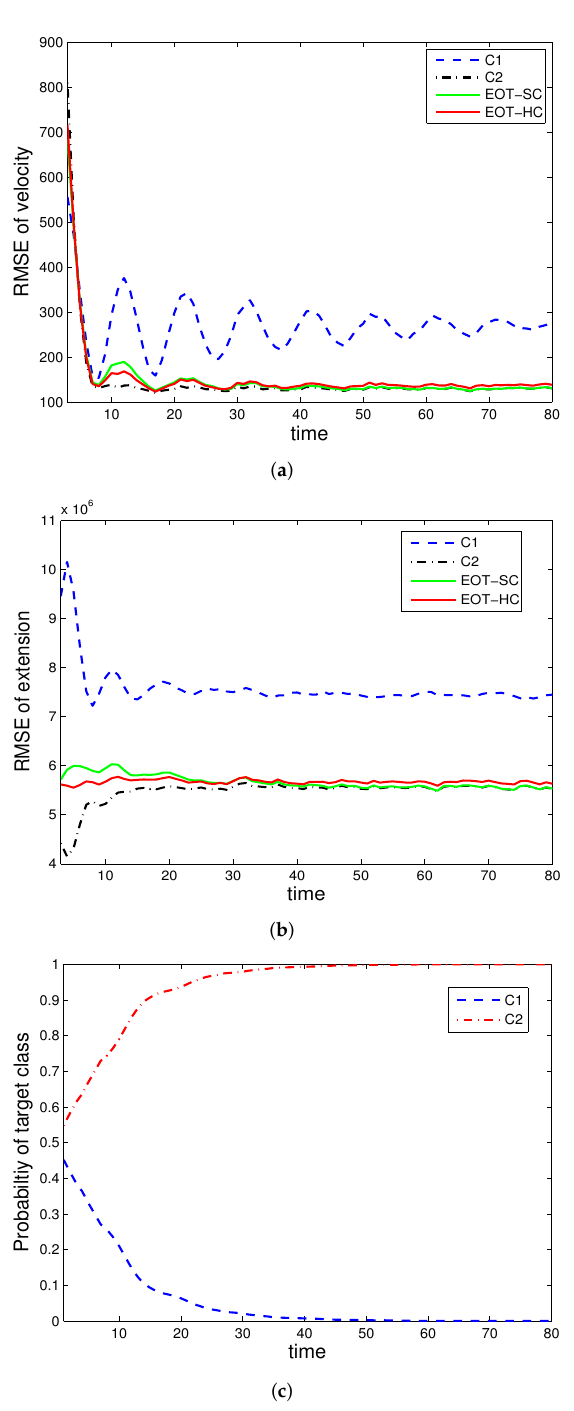
Figure 4. EOT-SC and EOT-HC using multisensor data, class c 2 is true: ( a ) RMSE of velocity, ( b ) RMSE of extension, ( c ) Probability of target